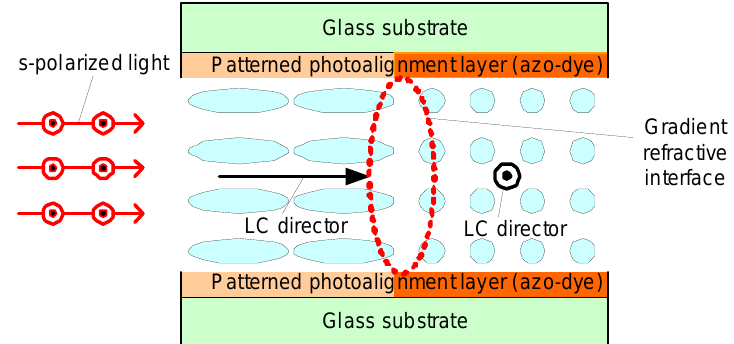
Figure 3. Formation of refractive interface for S polarized light by nematic liquid crystal inside the bulk of the LC cell